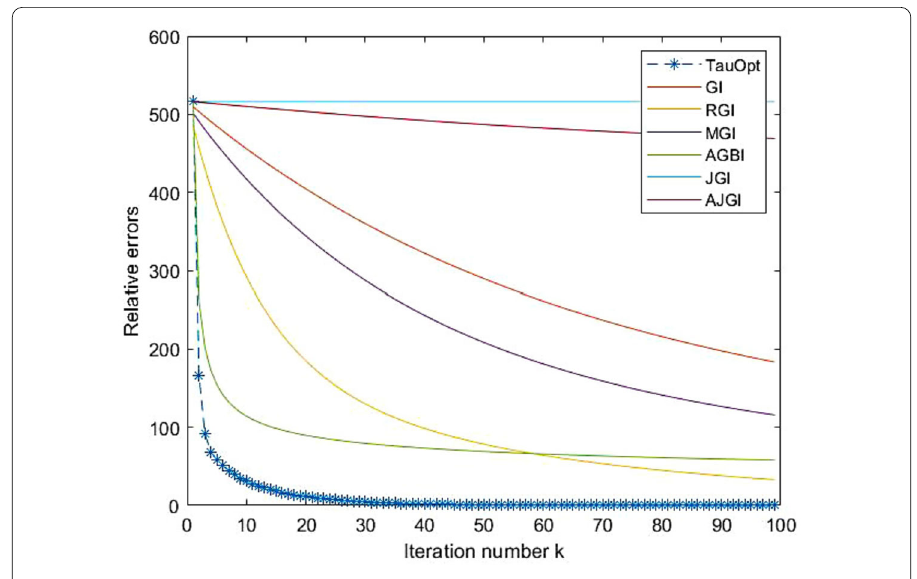
Figure 4 Relative errors for Ex. 5.4